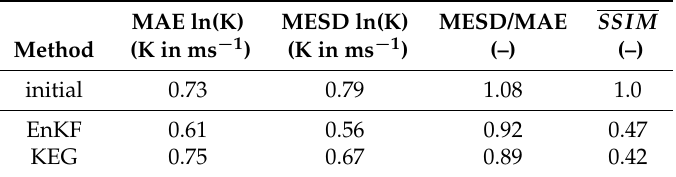
Table 3. Mean absolute error (MAE) of the ensemble-averaged log-K field, mean ensemble standard deviation of log-K (MESD), MESD/MAE ratio, and ensemble-averaged structural similarity index (SSIM) estimated after the assimilation of hydraulic data from pumping tests A and B. EnKF: ensemble Kalman filter. KEG: Kalman ensemble